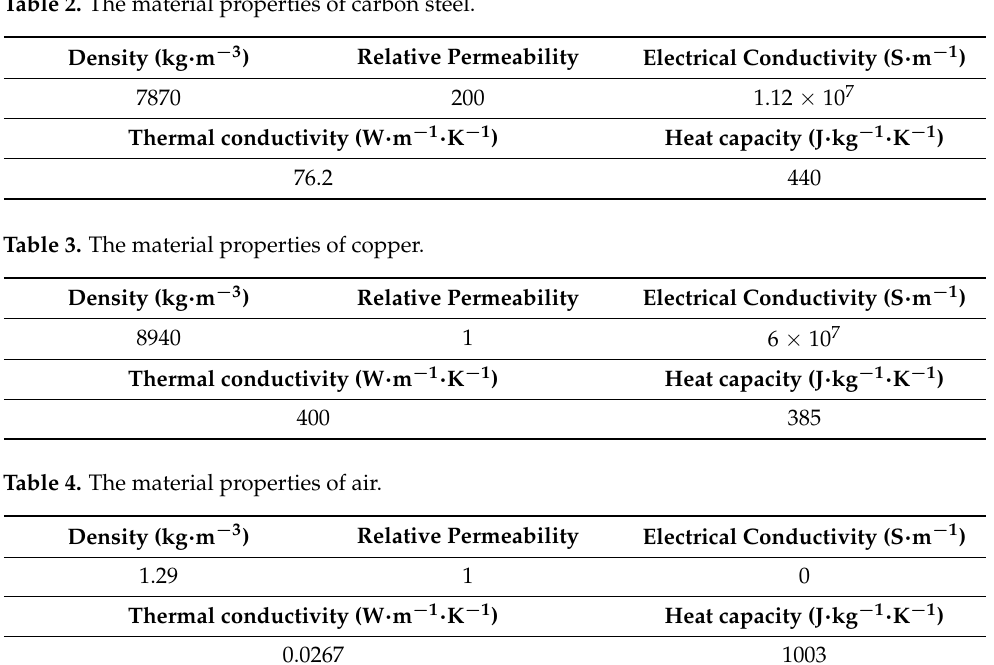
Table 2. The material properties of carbon steel.